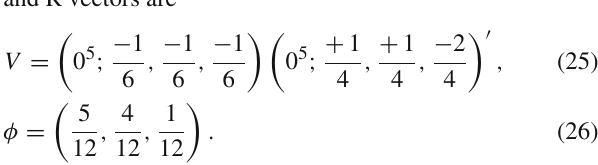
˜ N L , R are the oscillator numbers and 2 ˜ c 4 , 8 = 3 where are given in Ref. [41]. In the model of [41], the L 2 c 4 , 8 = 1 2 and R vectors are